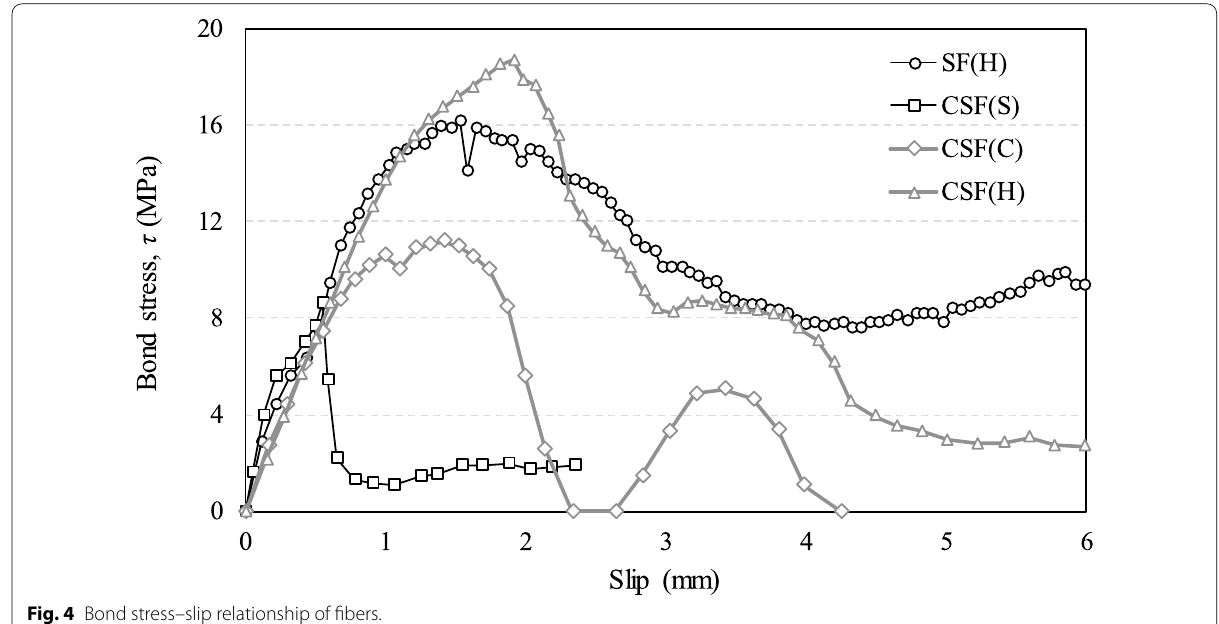
Fig. 4 Bond stress–slip relationship of fibers.